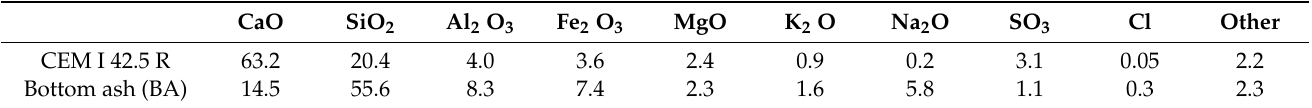
Table 1. Chemical composition of CEM I 42.5 R and BA (% by mass).